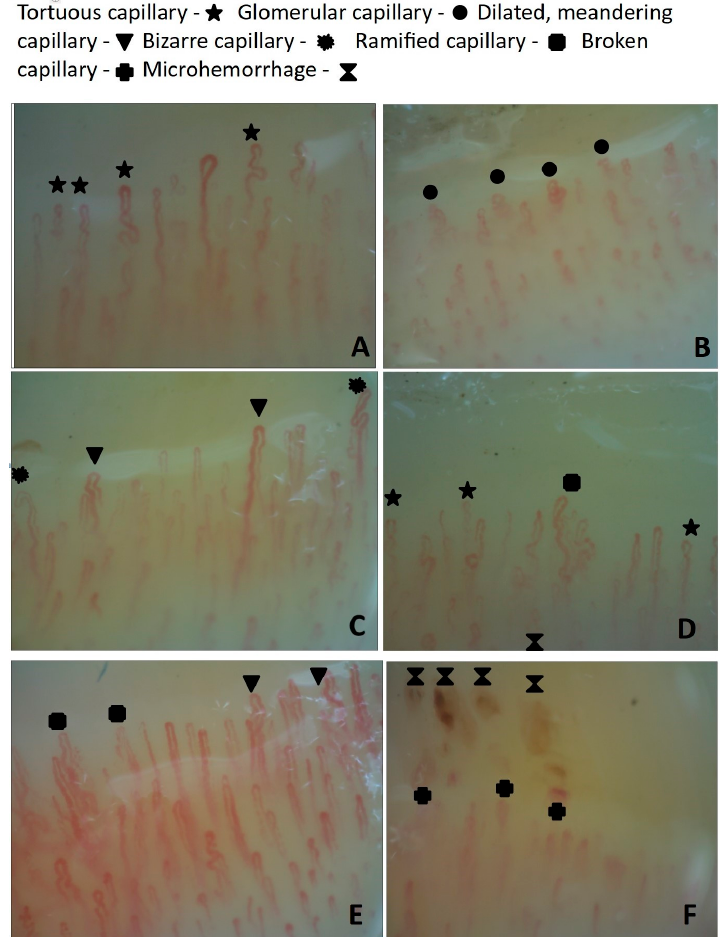
Figure 1. Capillary changes in patients with central serious chorioretinopathy (CSC): ( A ). Tortuous capillaries; ( B ). Glomerular capillaries; ( C ). Dilated, meandering and bizarre capillaries; ( D ). Tortuous, ramified capillaries, neoangiogenesis; ( E ). Dilated, meandering and ramified capillaries; ( F ). Abnormal distribution, broken capillaries, microhemorrhages.